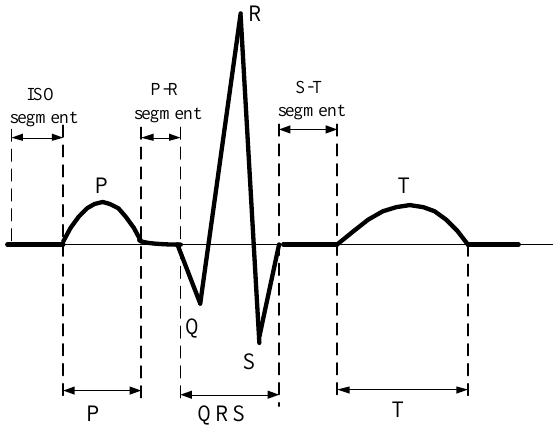
Figure 2. ECG typical elementary waveforms and